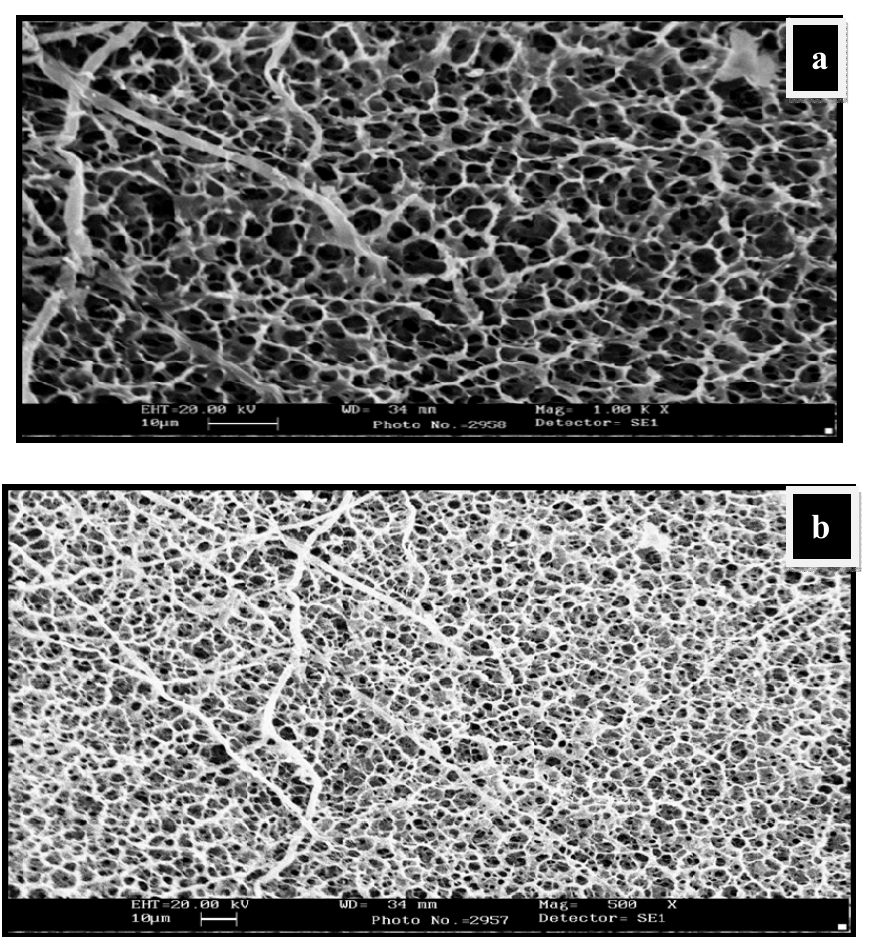
Figure 3. SEM micrographs showing water-swollen CG-0 hydrogel network: ( a ) Swollen structure at magnification 1.00K×; ( b ) swollen structure showing the interpenetrating network at magnification 500×.